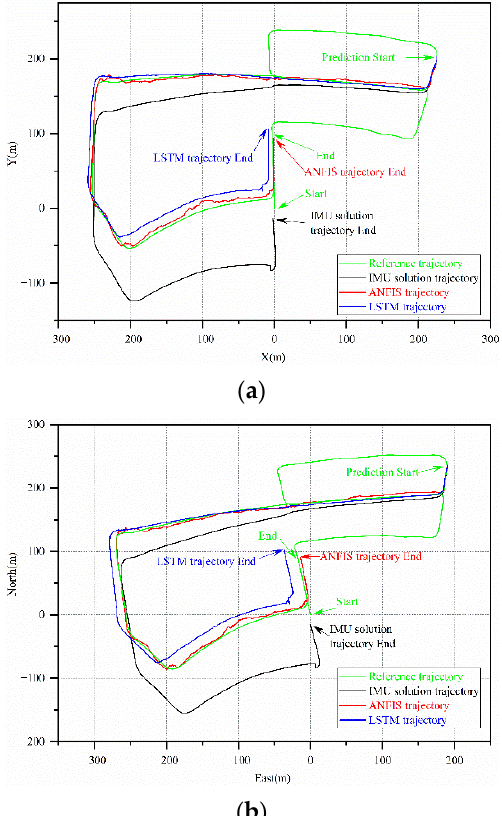
Figure 6. Comparison of INS solution trajectory, ANFIS trajectory, and true trajectory: ( a ) trajectory in the b 0 system; ( b )trajectory in the n system.